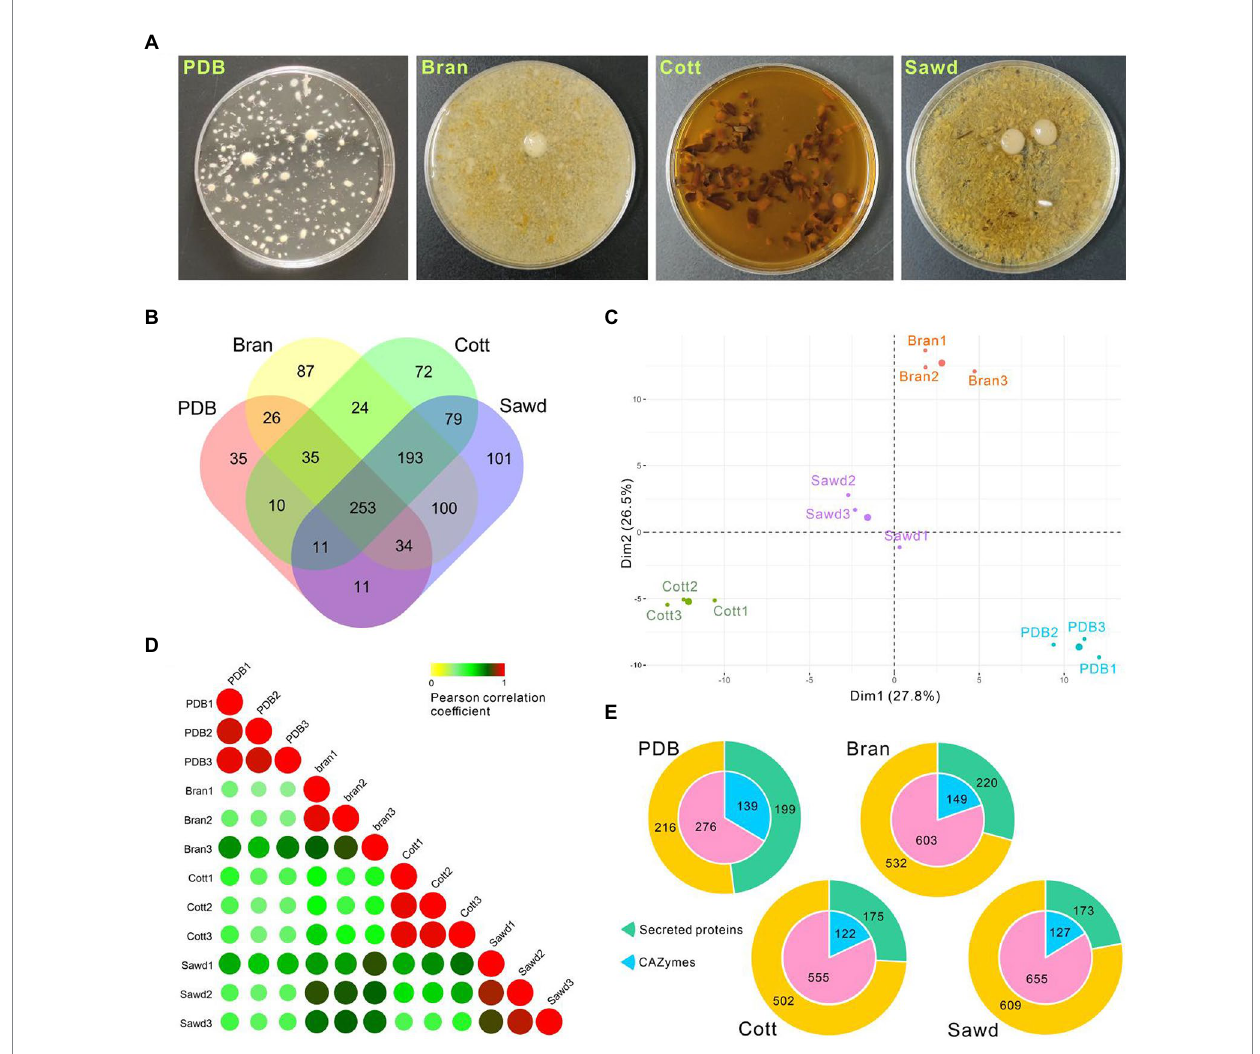
FIGURE 6 Proteomic analysis of Lyophyllum decastes secretome in different media. (A) Liquid cultivated L. decastes mycelia in different media. (B) Venn plot showing the identified proteins in four groups. (C) PCA of the first principal components based on common proteins identified from PDB, Bran, Cott, and Sawd groups. (D) Pearson correlation coefficients for pair-wise comparisons of proteome data from 12 samples. (E) Pie plots represent the identified CAZymes and secreted proteins of each group by proteomic analysis. Proteins that have a signal peptide and no trans-membrane region were recognized as secreted